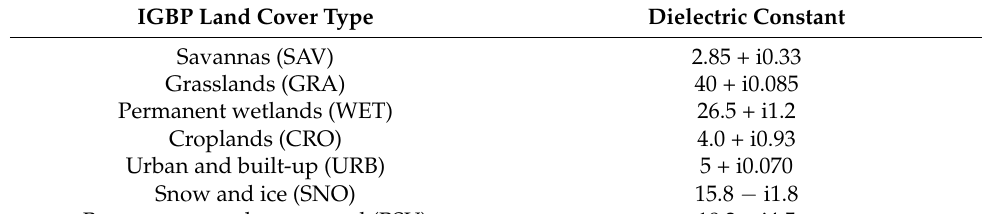
Table 3. Dielectric constant used on simulated intercity links.